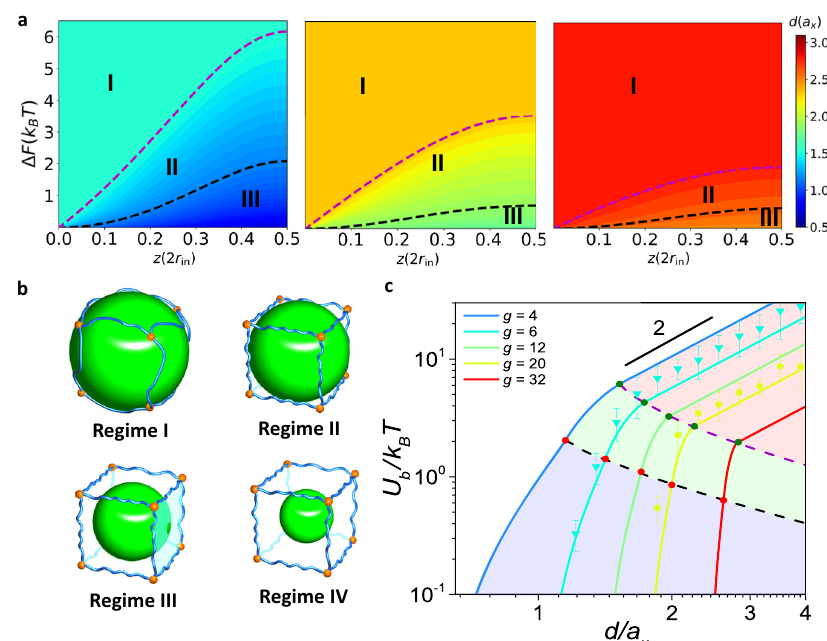
Fig. 3 Topology-dictated scaling regimes of free energy change. a Heat map of Δ F ~ z for various d in network cells at g = 4 (left), 20 (middle) and 32 (right). The color bar indicates the values of the particle diameter d . The boundaries of Regimes I and II and Regimes II and III are represented by purple and black dashed lines, respectively. Speci fi cally, the hidden Regime IV in each plot gives Δ F ( z ) = 0. b Schematic of spherical particles with various sizes in a network cell for different regimes: Regime I: r > r out , Regime II: r mid < r < r out , Regime III: r in < r < r mid , Regime IV: r < r in . c Free energy barrier of the particle between neighboring cells U b against d for various cell topologies. MC results are also plotted for topologies of g = 6 (blue), and 20 (yellow). The error bar indicates the standard